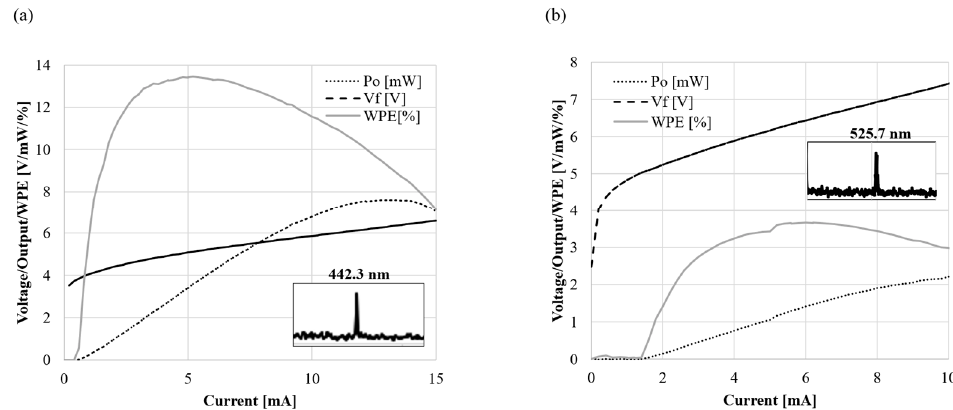
Figure 6. I-V/L and I-WPE curves of ( a ) blue [31] and ( b ) green VCSELs [36] with a curved mirror. The insets are the emission spectra obtained from the above threshold currents.